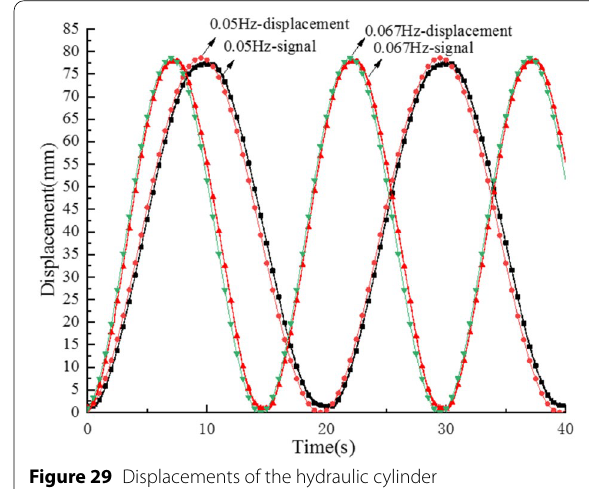
Figure 29 Displacements of the hydraulic cylinder